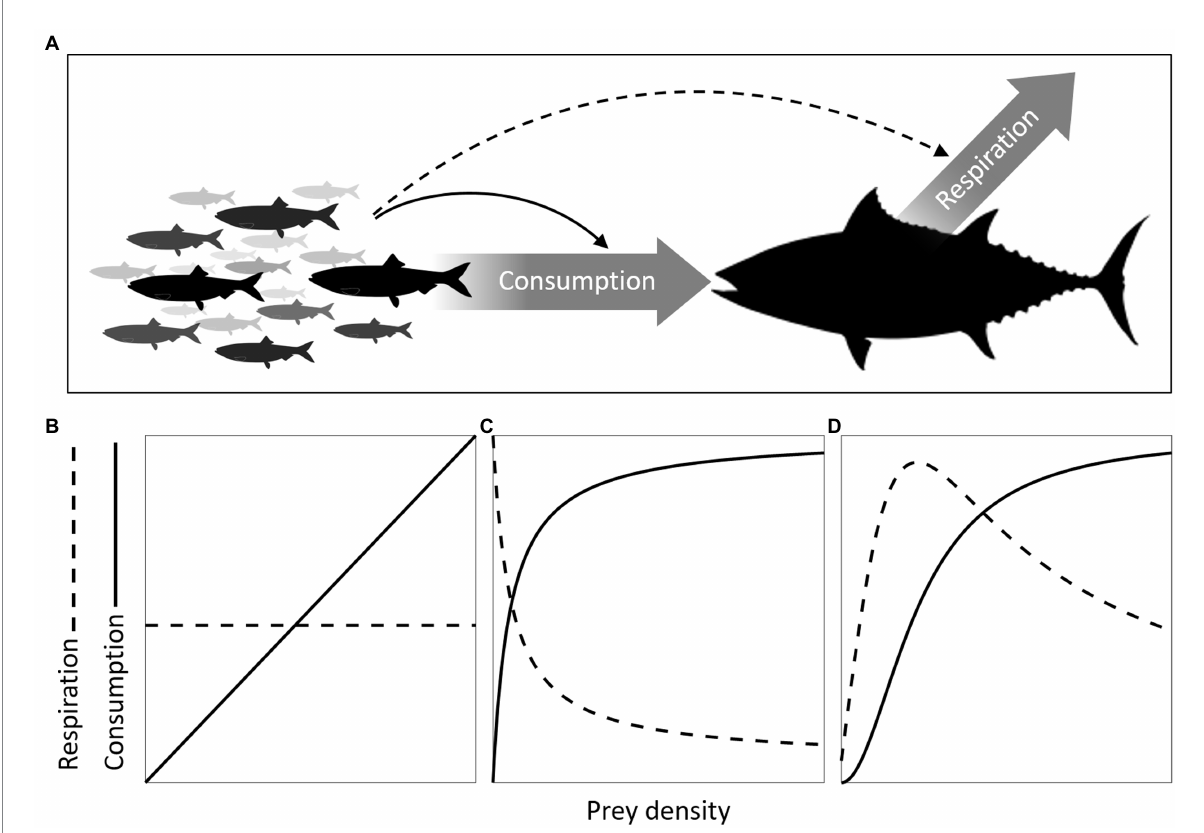
FIGURE 1 Functional and metabolic responses. (A) two major components of energy flow in predator organisms are food consumption and respiration rates (thick arrows). Prey density can influence predator dynamics through its influence on consumption (continuous arrow) and/or its influence on respiration (dashed arrow), configuring the functional and metabolic responses, respectively. As both responses can be mediated by changes in foraging effort, the three typical functional response curves (I, II, and III, Holling, 1959a) can be linked to their expected metabolic response counterparts (B–D) . A type I functional response is the simplest and results from constant foraging effort leading to prey encounter rates that are proportional to prey density (B, continuous line), so the associated type I metabolic response is a constant (dashed horizontal line). A type II functional response is characterized by saturation of consumption rates at high prey densities (C) . The associated type II metabolic response is a hyperbolic decline in metabolic expenditure (a negative response), reflecting a decline in the foraging effort required to reach a certain level of consumption as prey density increases. This same decline in foraging also explains the decelerating shape of the functional response (see the Supplementary material for mathematical derivation). In some cases, if prey density decreases to very low levels, it can be beneficial for the forager to slow down the rate of foraging and save energy. This results in a hump-shaped relationship between prey density and foraging effort and consequently a hump-shaped metabolic response (D) , which is a type III metabolic response as the functional response emerging from the same foraging strategy has the characteristic sigmoidal shape. These associations between functional and metabolic response types are not supposed to be rigid though, they were chosen as archetypical expectations assuming both responses result solely from changes in foraging effort. Other associations may be possible in circumstances where functional responses are shaped by different